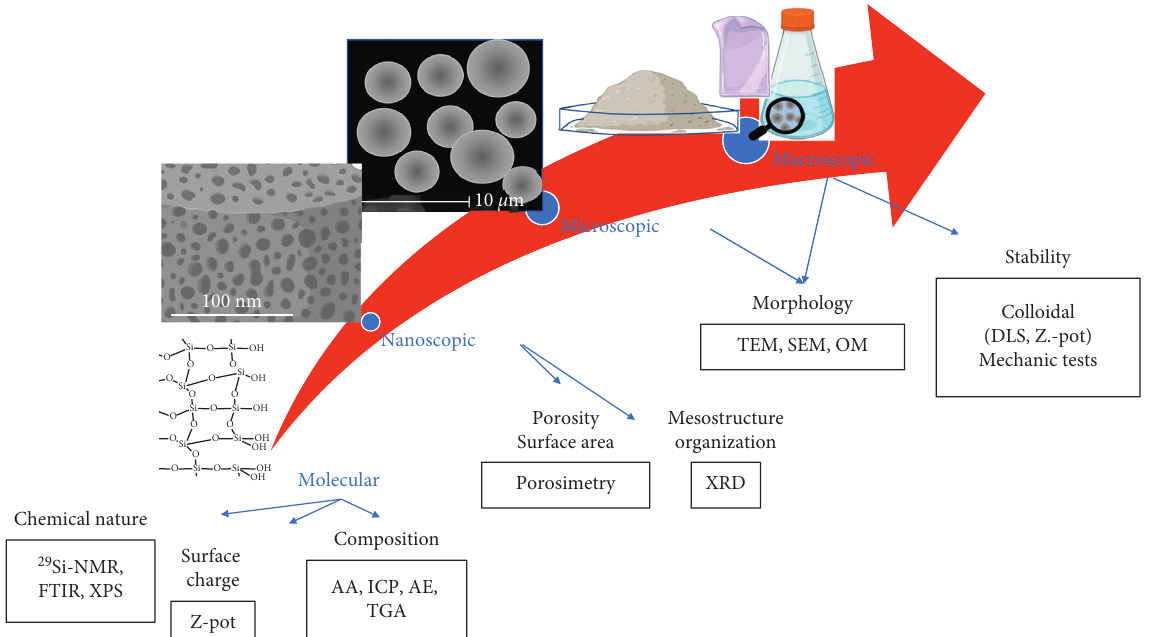
Figure 1: Silica properties and common characterization techniques at different